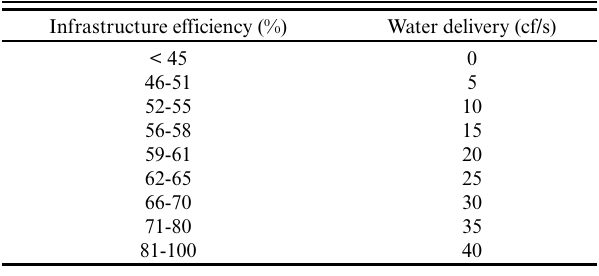
Table 2 . Production function of water delivery as a function of infrastructure efficiency.